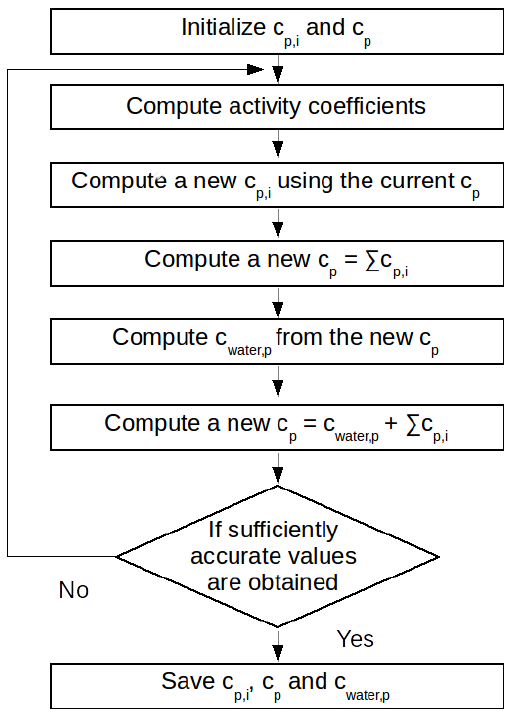
Figure 1. Computation steps for the gas–particle partitioning and the water absorption.